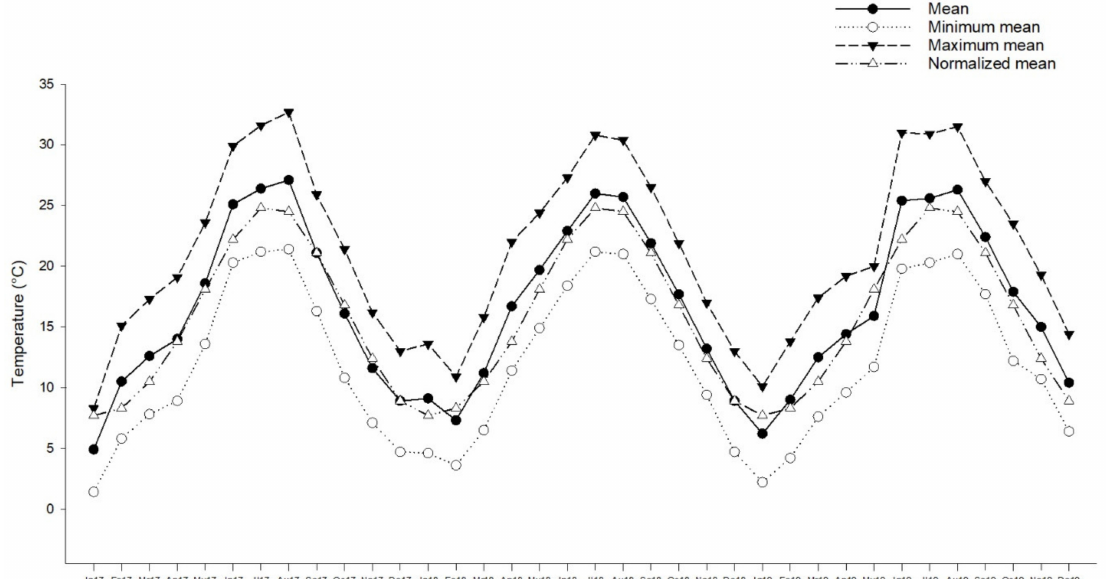
Figure 3. Average, minimum, and maximum monthly temperatures of 2017–2019 and the pluriannual mean ( ◦